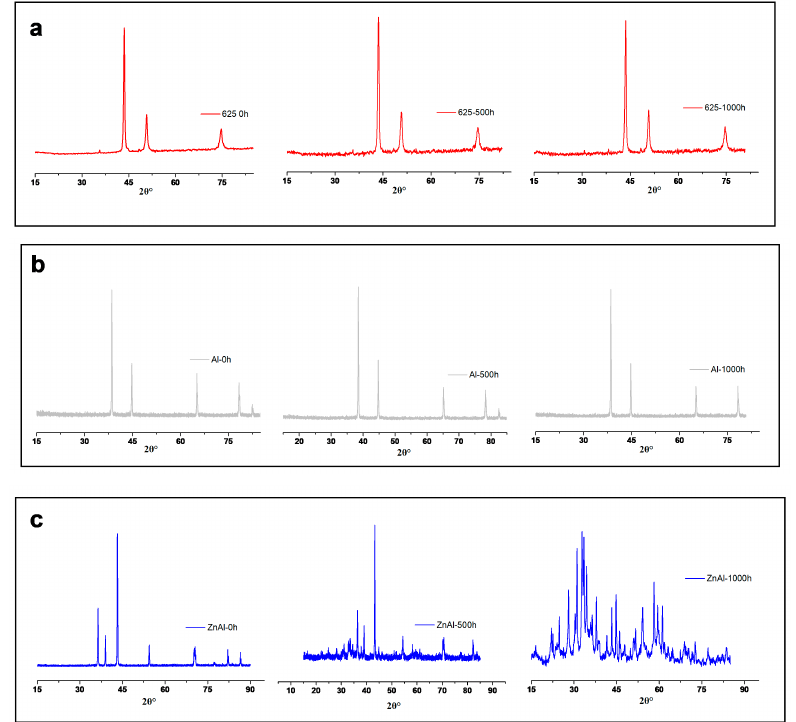
Figure 6. XRD spectra of three thermal spray coatings after the 3.5 wt % NaCl immersion corrosion test: ( a ) Inconel 625 alloy; ( b ) Al; and ( c ) ZnAl, at 0, 500, and 1000 h from left to right.